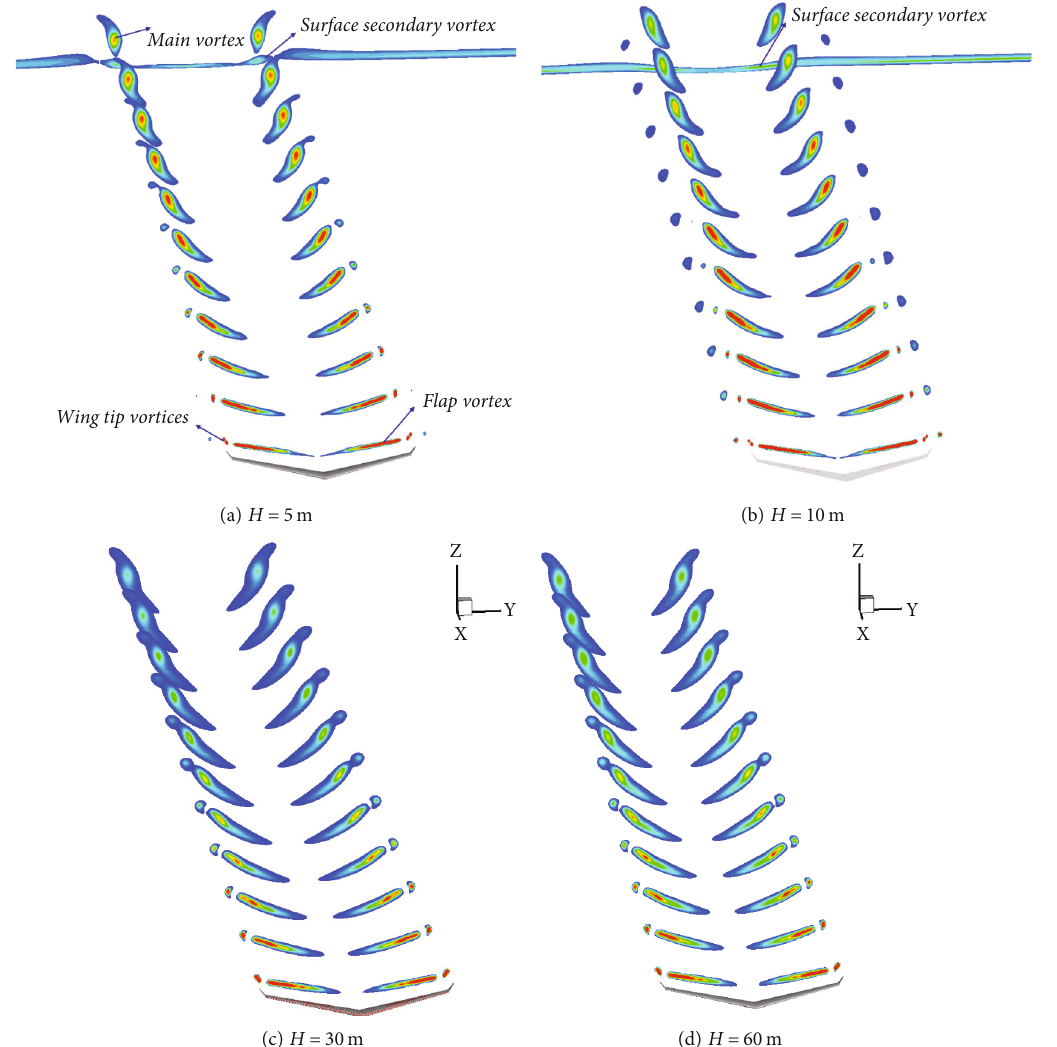
Figure 5: The vorticity distribution at di ff erent